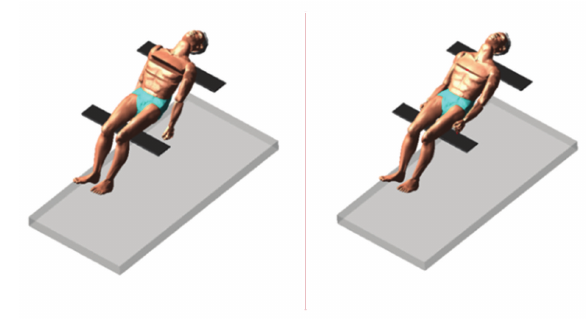
Figure 11: The simulation results comparison.